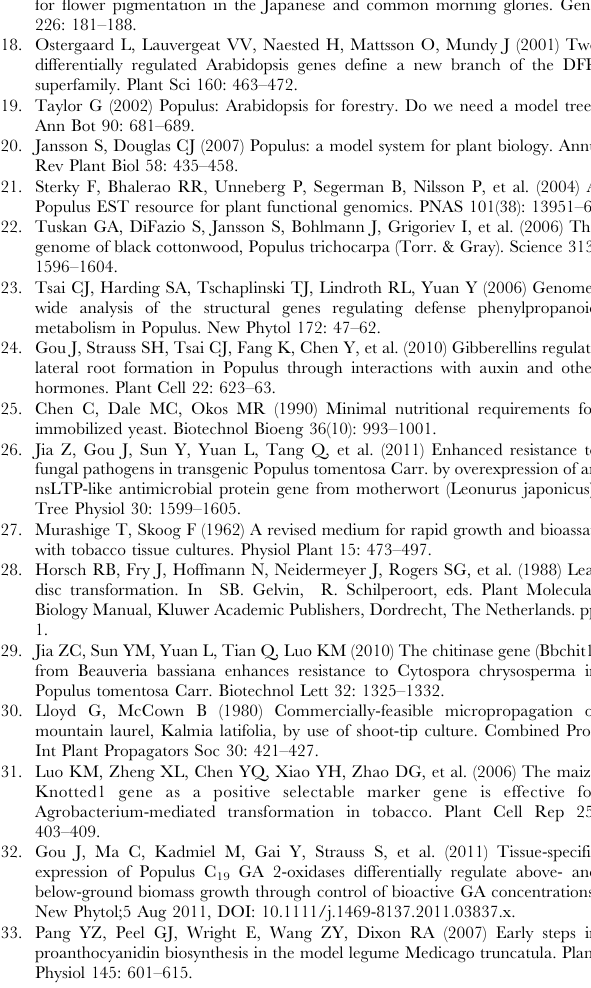
Figure S1 PCR analysis of transgenic tobacco plants. ( A ) PCR amplification using primers specific for the production of a 741-bp NPTII fragment. ( B ) PCR amplification using primers specific for the production of a 1,375-bp PtrDFR1 fragment. ( C ) PCR amplification using primers specific for the production of a 1,128-bp PtrDFR2 fragment. M, D2000 DNA Ladder; WT, wild- type plants; pBI121, transgenic control; Plasmid, corresponding plasmid DNA (positive control); Lanes 1–16, independent